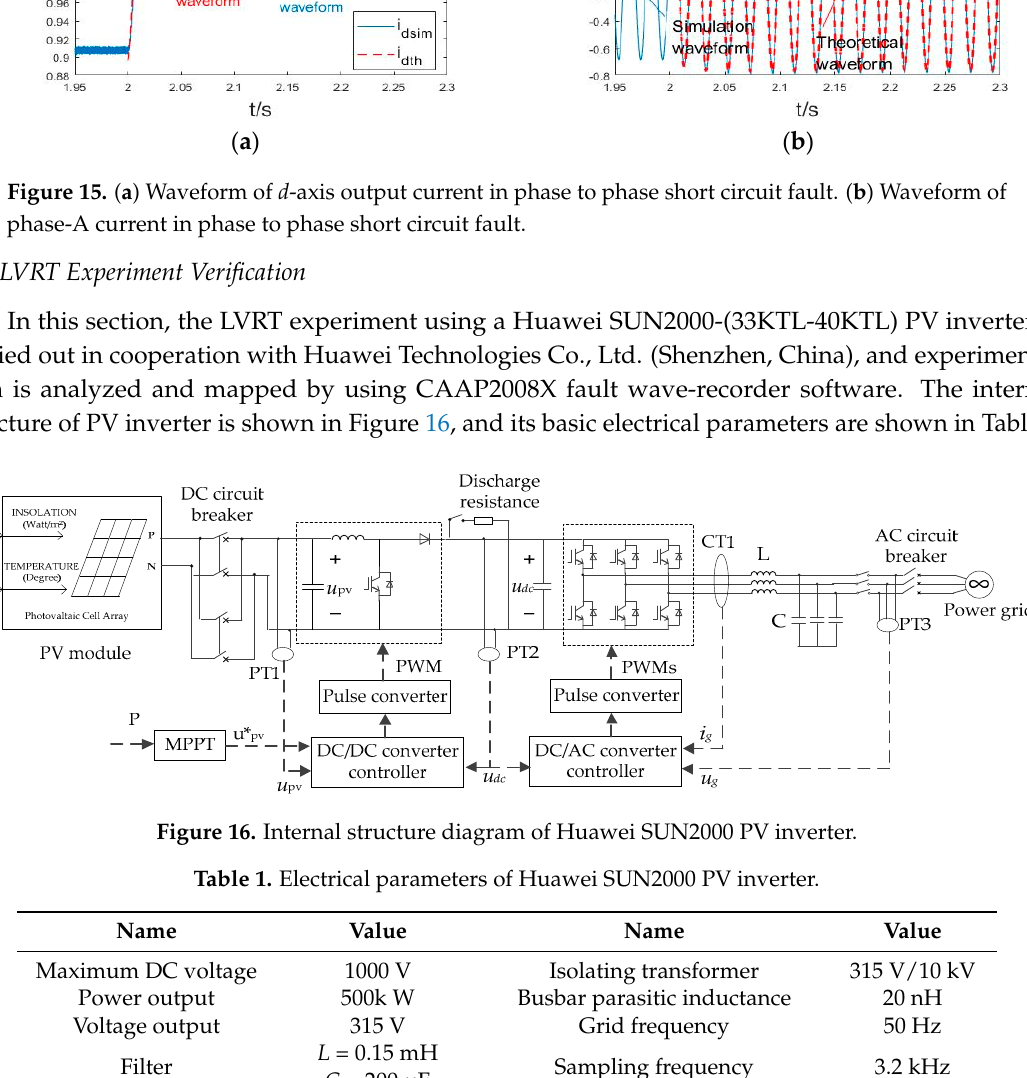
of phase-A current in phase to phase short circuit fault.